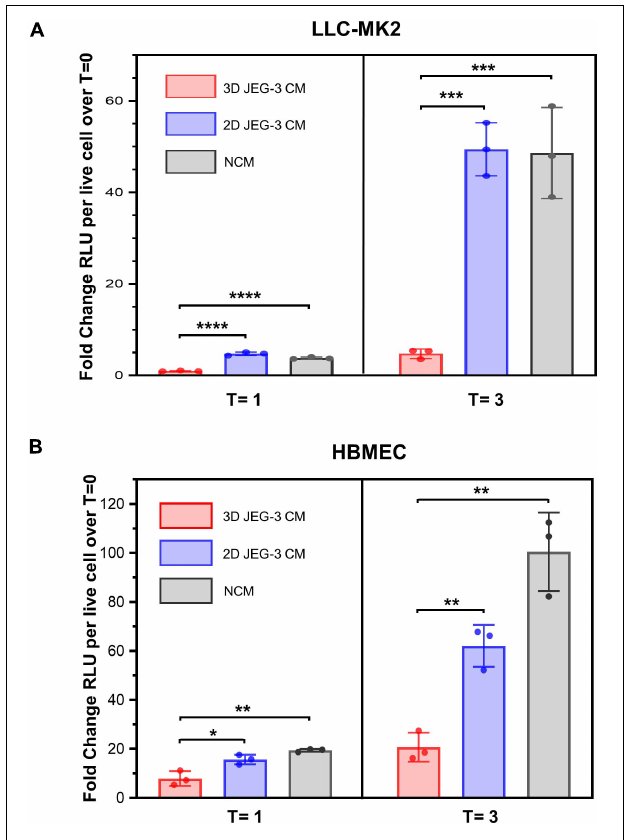
FIGURE 5 | 3D cultures of JEG-3 cells release paracrine factors that prevent T. cruzi infection of non-trophoblastic cells. (A) LLC-MK2 or (B) HBMEC cells were preincubated with supernatants from 2D JEG-3 (2D CM), 3D JEG-3 (3D CM) or non-conditioned medium (NCM) (LLC-MK2 or HBMECs culture medium) for 24 h followed by infection with T. cruzi- luminescent parasites (5 parasites per live cell). Nanoluciferase activity was measured as relative luminescence units (RLU) at 0 ( T = 0), 1 ( T = 1), and 3 ( T = 3) dpi. Data were normalized to the number of live cells and represent the mean ± SD of three technical replicates. The fold change RLU values per live cell over T = 0 were plotted. The experiment was repeated two times with similar results. In all panels, asterisks indicate statistically significant differences calculated using an unpaired t -test. * P ≤ 0.05; ** P ≤ 0.01; *** P ≤ 0.001; **** P ≤